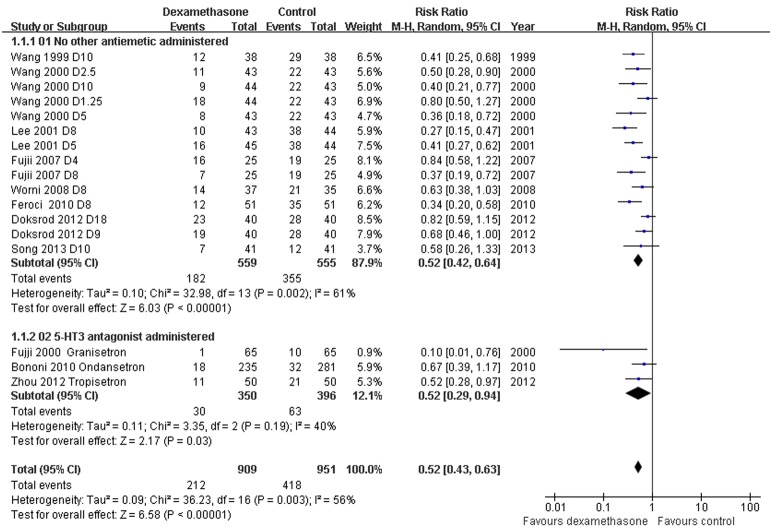
Incidence of PONV grouped by concomitant anti-emetics.Eleven studies described the incidence of PONV in thyroidectomy patients treated with dexamethasone versus placebo with or without concomitant anti-emetics (RR 0.52, 95% CI 0.43 to 0.63, P<0.00001). There was evidence of significant heterogeneity between studies (P = 0.003, I2 = 56%).